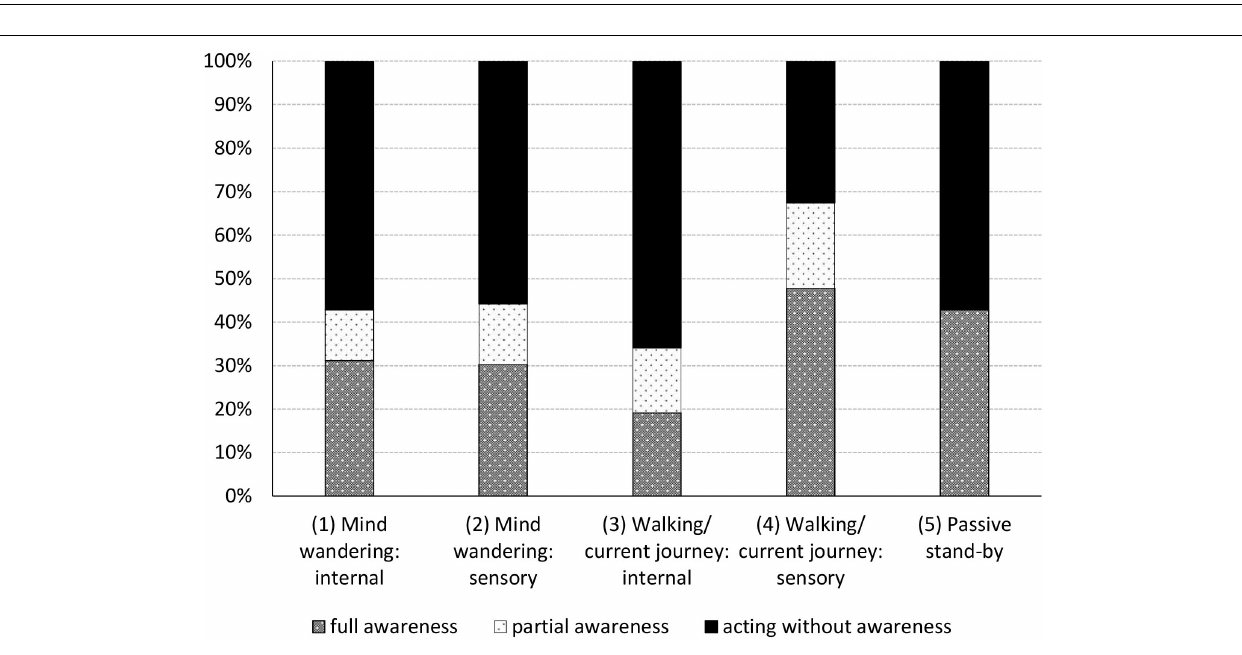
FIGURE 4 | The moment participants move to avoid the signboard differed significantly between the various overt secondary tasks ( p = 0.004). When excluding talking – which is the main overt secondary task for those walking together – this difference largely disappeared ( p = 0.070).